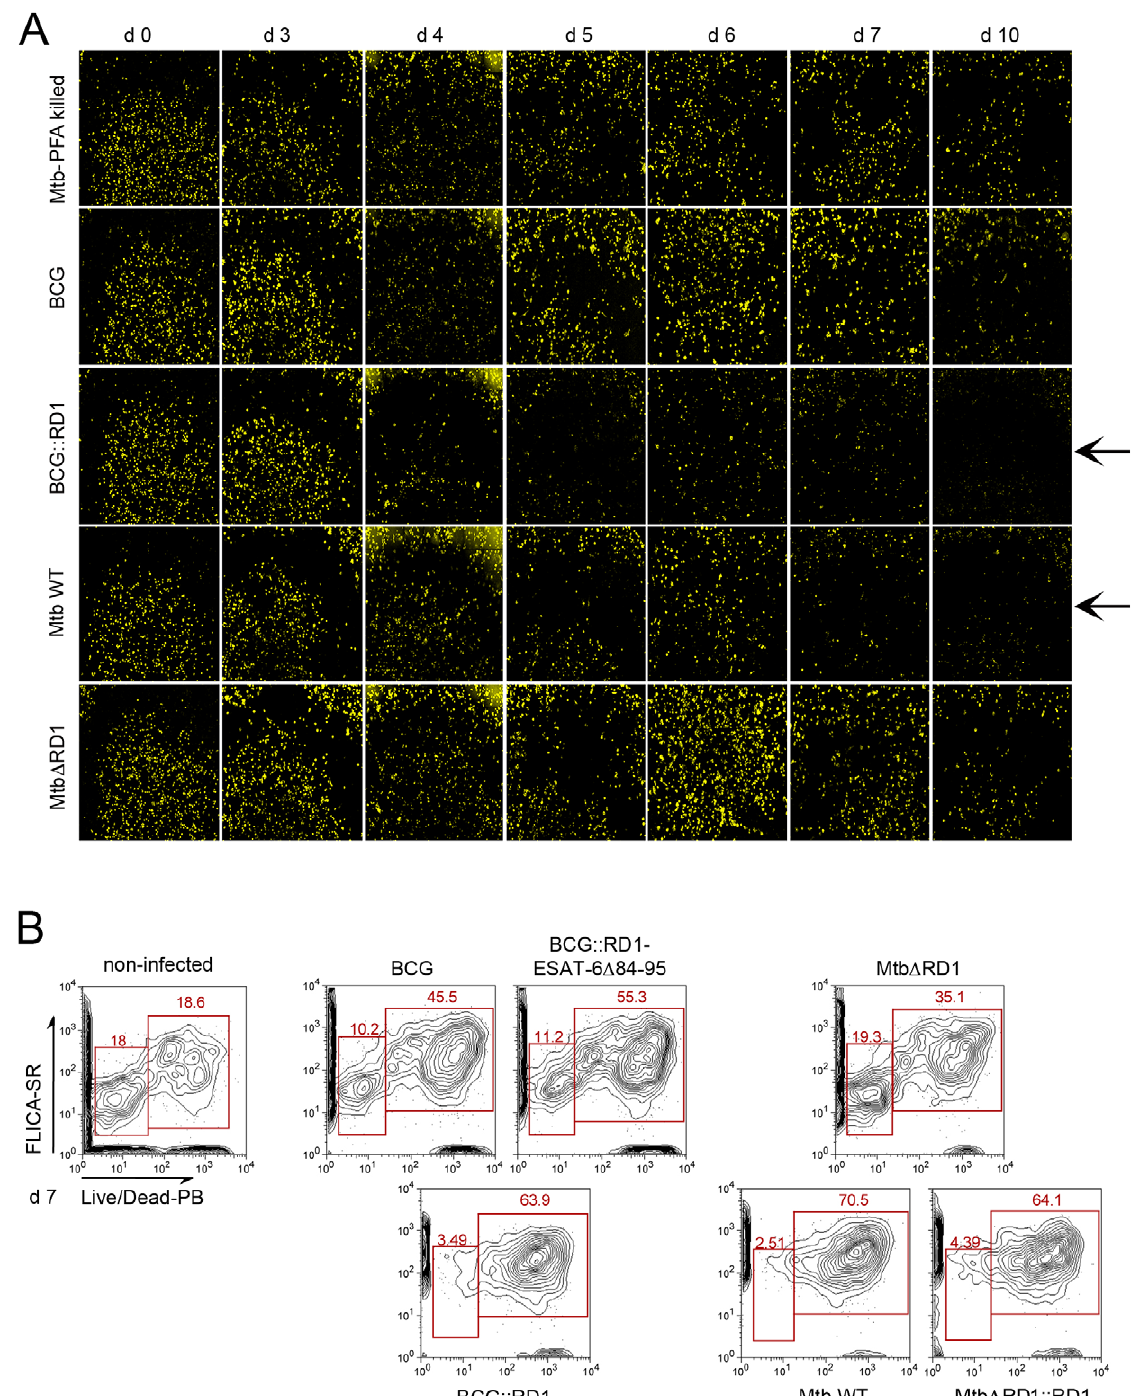
Figure 4. Evolution of cell numbers during the time course of infection with different M.tuberculosis complex members. THP-1 cells were infected with M. tuberculosis PFA killed, BCG, BCG::RD1, M. tuberculosis or M. tuberculosis D RD1 at a MOI of 1 for the indicated time. Arrows indicate the decrease of the number of cells with virulent strains. After PFA fixation, cells were stained by incubation with WGA (wheat germ agglutinin) and imaged using a Nikon Ti widefield microscope. Pictures represent a mosaic of 49 individual images from 96 well plates acquired with a 20X objective (A). Cytofluorometry analysis of THP-1 cells infected with various wild-type and recombinant M. tuberculosis and BCG strains at day 7 post-infection. THP-1 cells were stained with FLICA Poly-Caspases SR-VAD-FMK (apoptosis) and Live/Dead Pacific Blue (necrosis) (B).